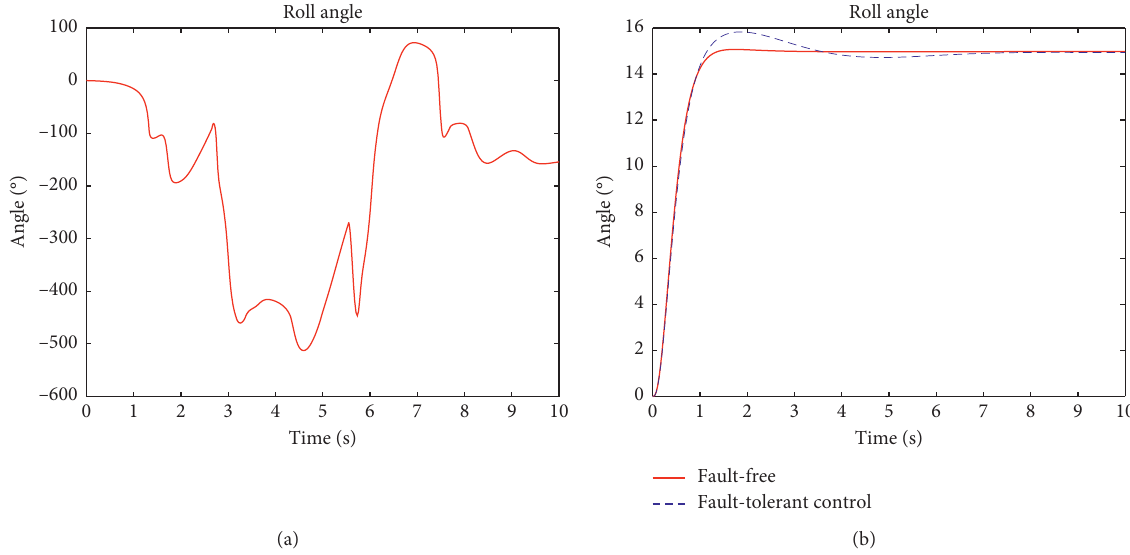
Figure 6: Comparison diagram of the roll angle before and after fault-tolerant control. (a) Non-fault-tolerant control. (b) Fault-tolerant control.